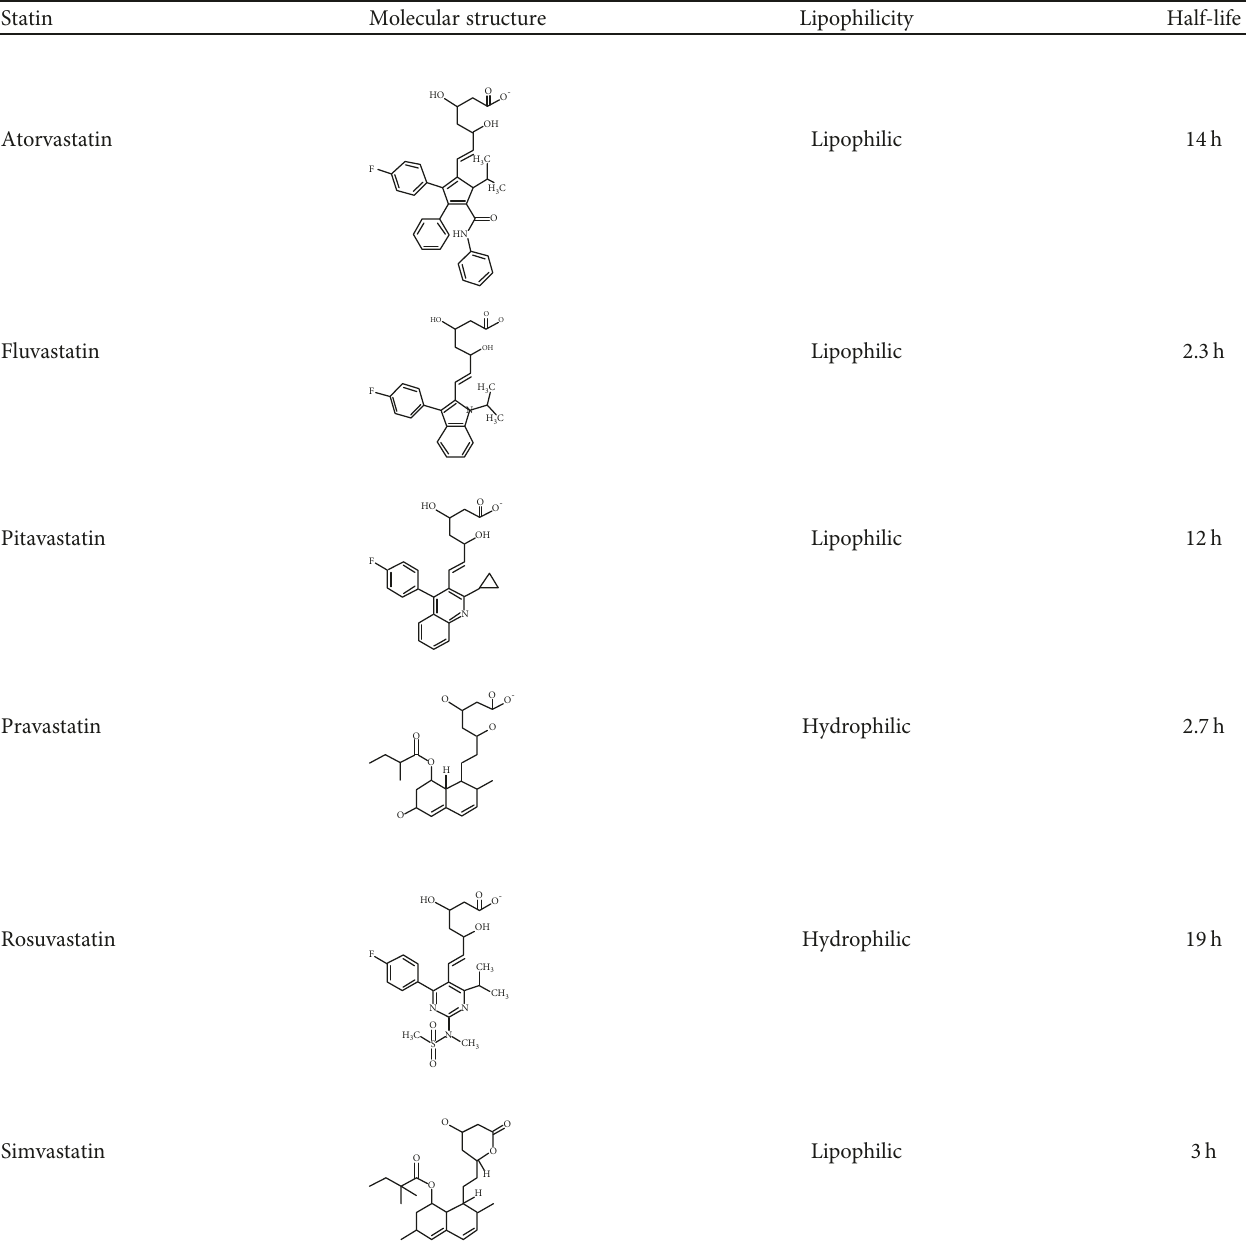
Table 1: Chemical structure and properties of the commonly prescribed statins